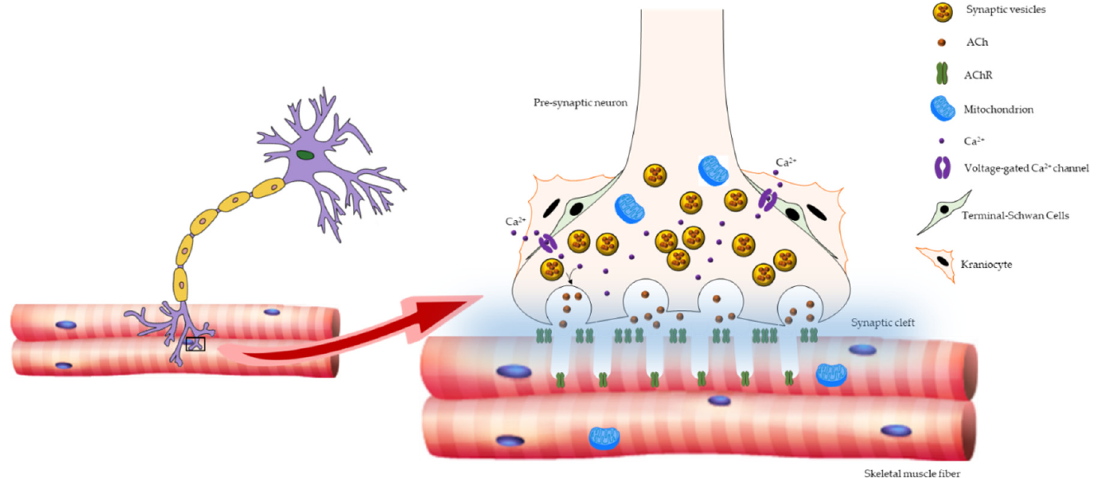
Figure 1. Schematic representation of NMJ architecture. NMJ is composed of three major elements: the presynaptic motor nerve terminals packed with synaptic vesicles containing the neurotransmitter ACh; the synaptic cleft; and the deeply folded postsynaptic membrane of the muscle fiber, where AChRs are placed. The NMJ-associated cells, tSCs, and kranocytes are also shown.